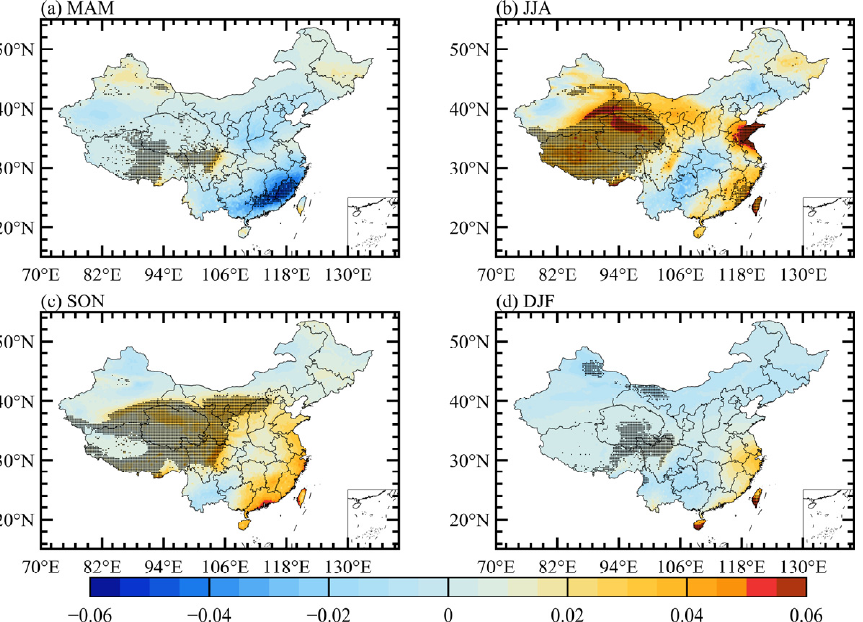
Figure 3. Spatial distribution of seasonal PW trends over China during 1979–2020 (unit: kg·m − 2 ·yr − 1 ). The stippled areas indicate that the trends passed the significance test at the 95% confidence level. ( a ) Spring, ( b ) Summer, ( c ) Autumn, ( d ) Winter.